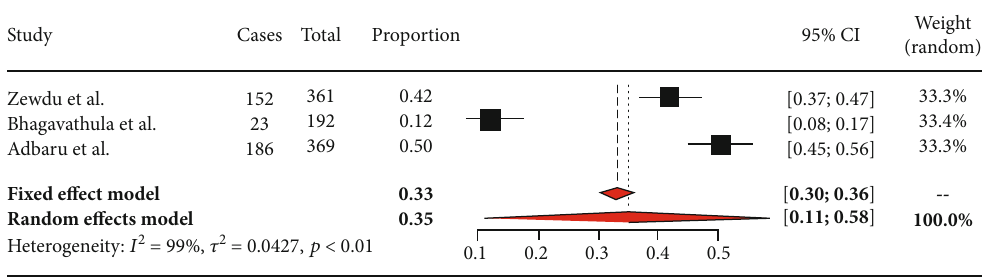
Figure 3: Forest plot showing burnout among nurses in Amhara